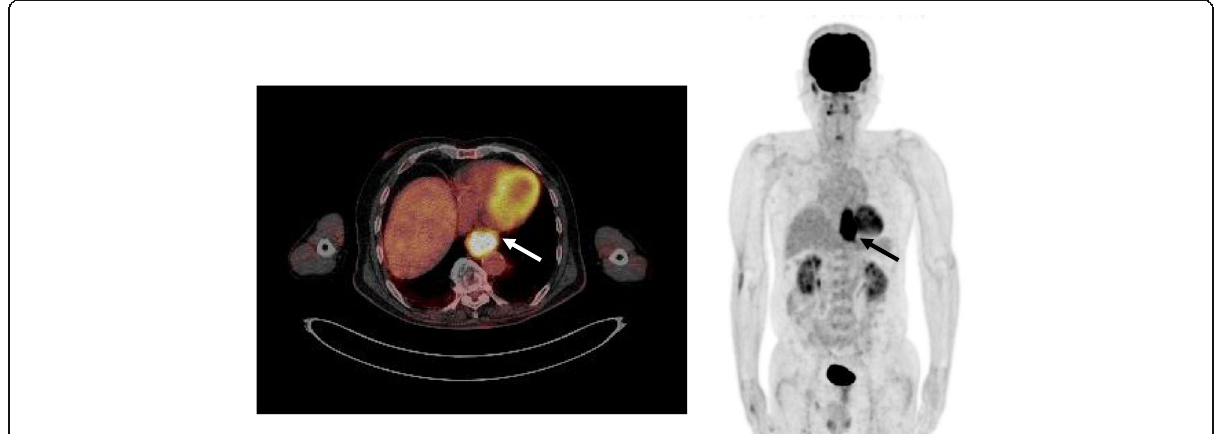
Fig. 5 Positron emission tomography (PET)-CT revealed accumulation of fluorine-18-2-fluoro-2-deoxy-d-glucose (FDG) in the lower thoracic esophagus, with a standardized uptake value of 8.8